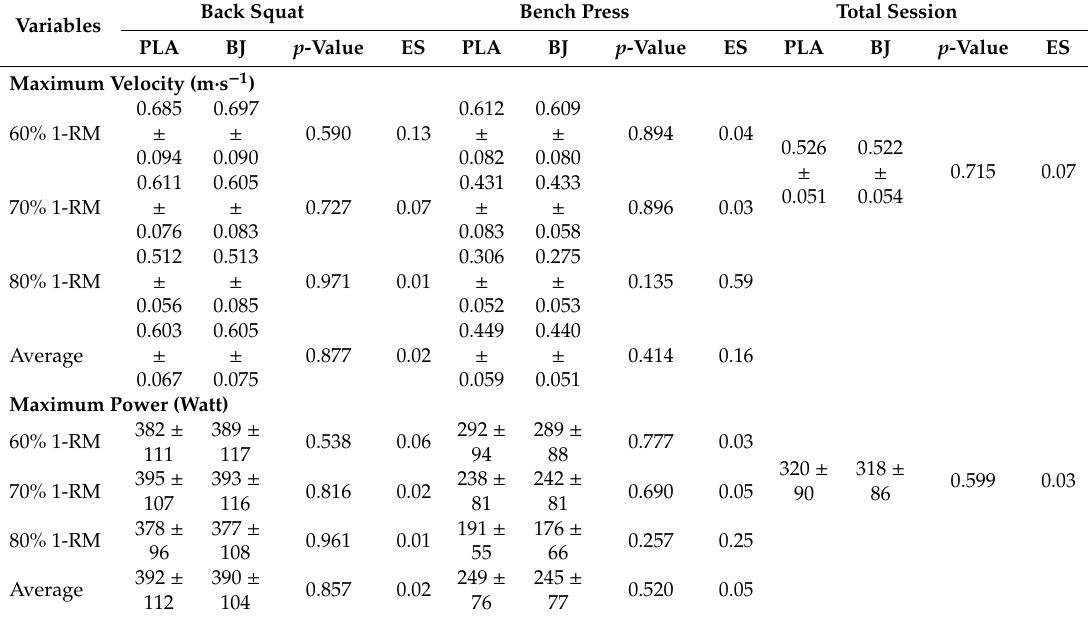
Table 2. Movement concentric velocity control for back squat, bench press, and total session after the consumption of placebo or beetroot